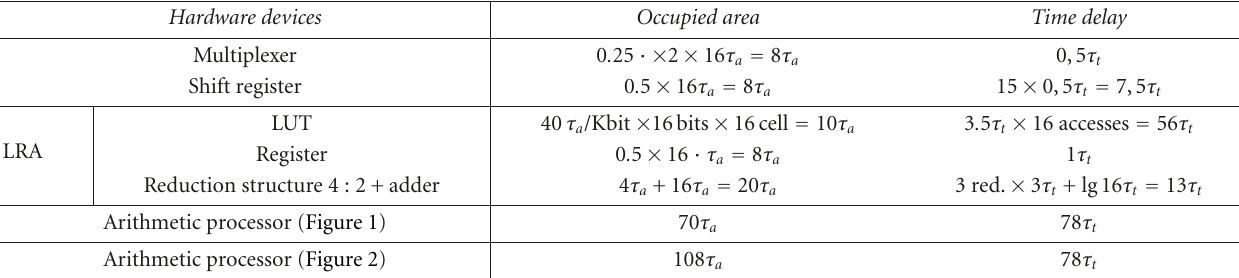
Table 5: Arithmetic processor estimations of area cost and time delay for 16bits and one-bit fragmented data.